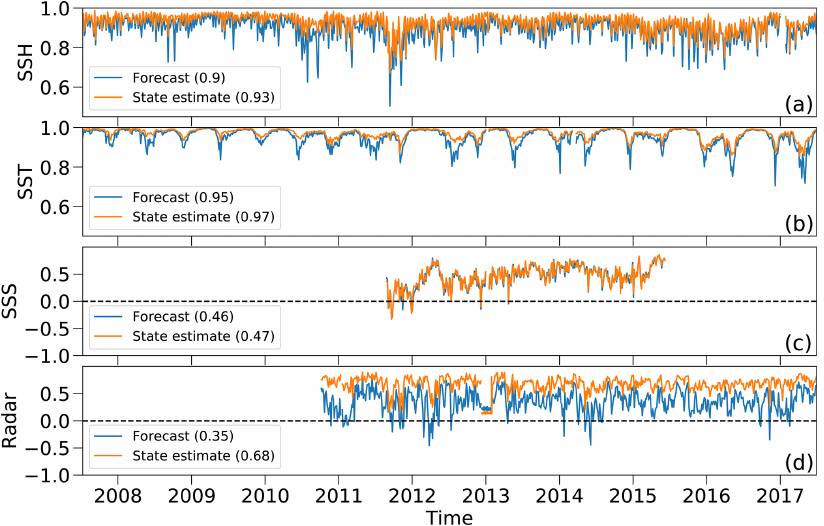
Figure 8. Time series of anomaly correlation coefficients (ACC) between remotely sensed observations and two model realizations; the state estimate (orange) and the forecast (blue). (a) Sea surface height; (b) sea surface temperature; (c) sea surface salinity; and (d) HFRs.